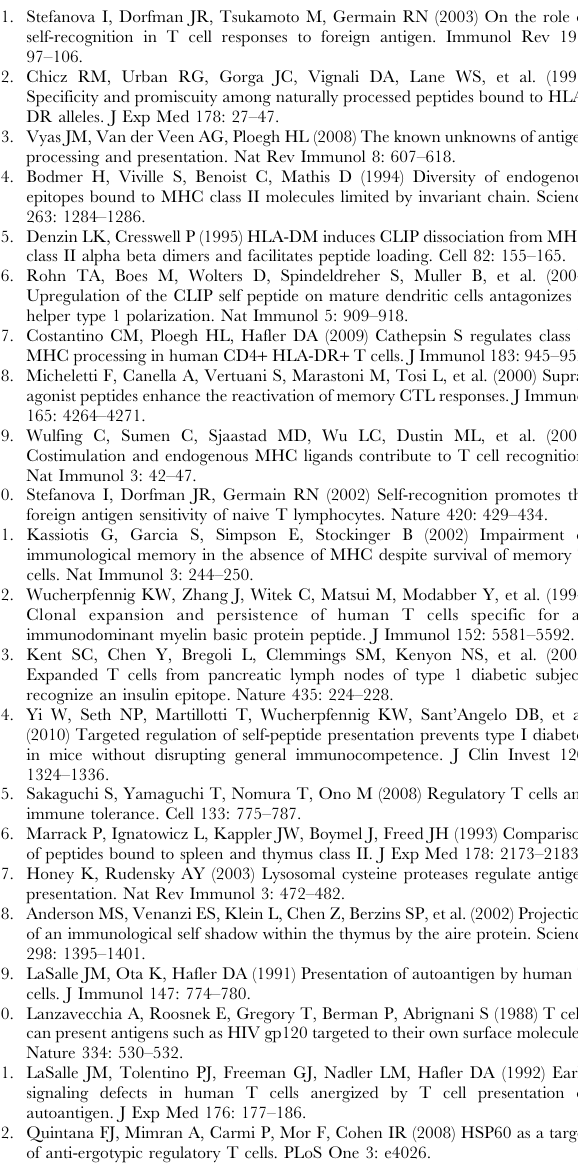
Table S4 List of peptides identified in the T cell samples or in the B cell samples from Donor 2. Table S5 Non-self peptides identified during protein elution, for both